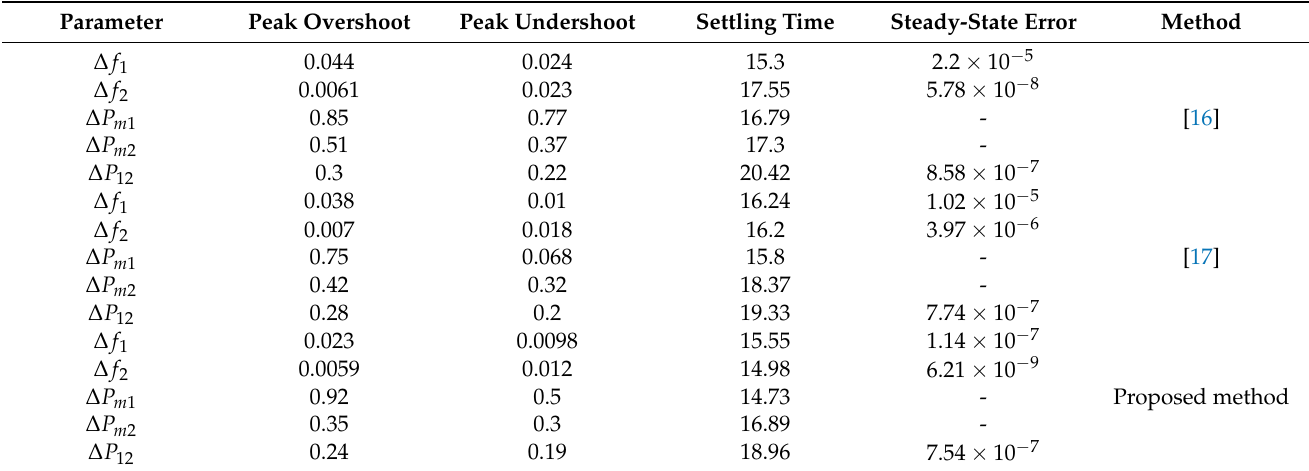
Table 3. Comparison of transient specifications of the proposed approach with other existed works for random load demand